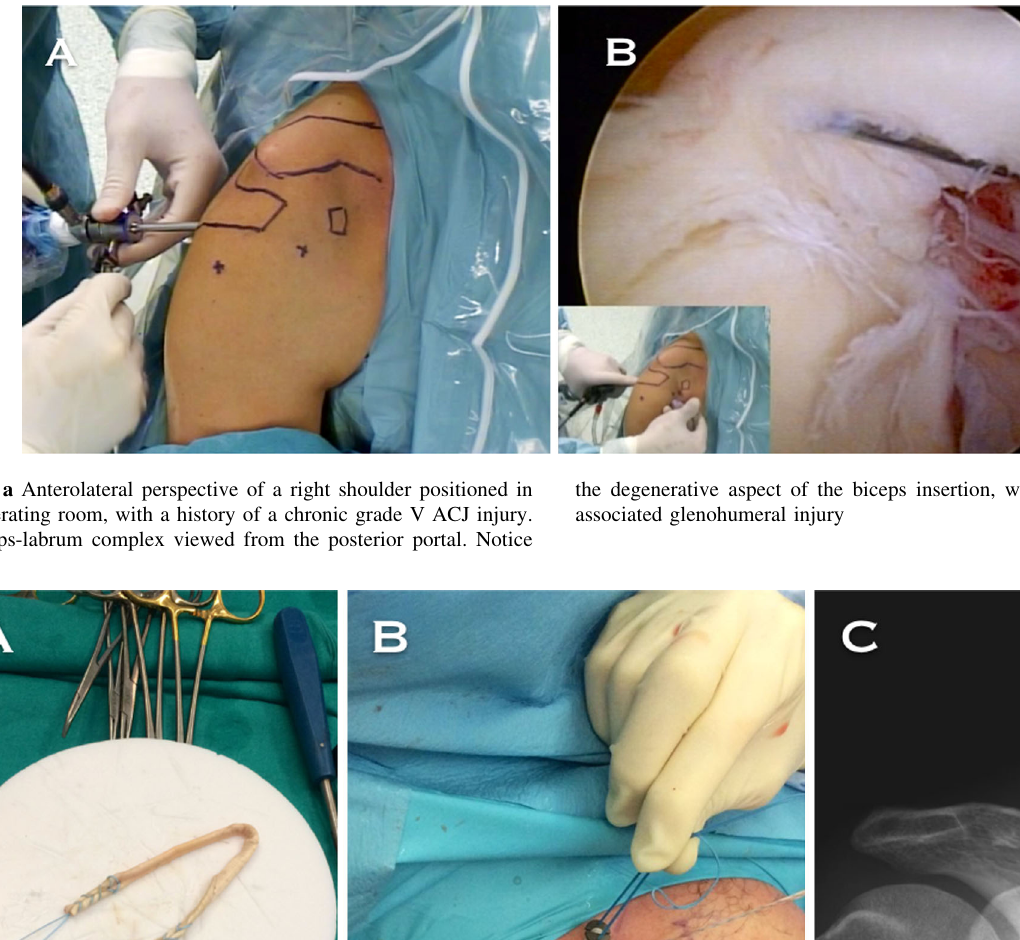
anatomical reconstruction of CC ligaments with tendon allograft was performed in the chronic setting. Observe the trapezoid tunnel in the clavicle, lateral to the conoid tunnel in the clavicle, through which also passes the suspension